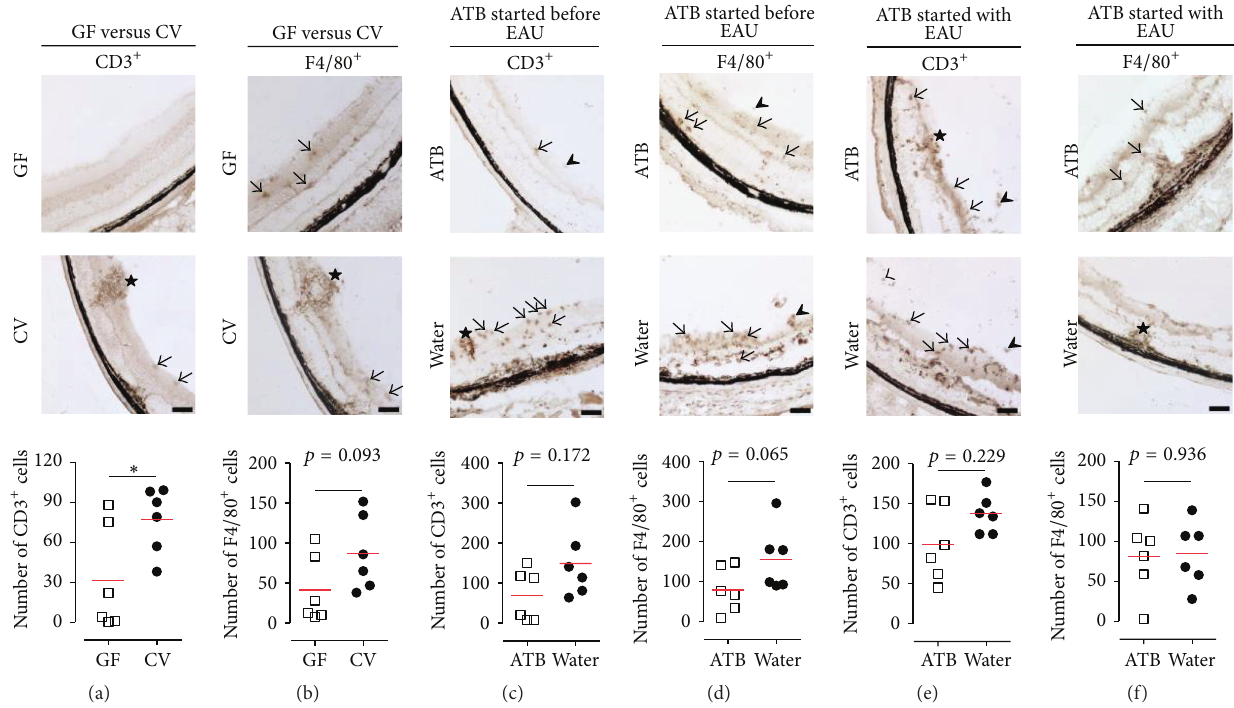
Figure 4: T cell and macrophage infiltration of the retina from germ-free (GF) mice (a, b), from mice treated with antibiotics (ATB) administered from one week (c, d), or from the day of EAU induction (e, f) and conventional (CV, water) mice 35 days after EAU induction. (a, c, e) CD3 + cells (T-lymphocytes) are shown both distributed as single cells in inner and outer retinal layers (arrows), in the vitreous (arrowheads) and concentrated as clumps in granulomas (stars). (b, d, f) F4/80 + cells (macrophages) are either present as single cells, in inner retinal layers (arrows), or accumulated in the periphery of granulomas (stars). Each point in the graphs shows the sum of all positive cells counted in two sections, one from periphery and one from the centre, from one randomly selected eye. The red lines in the graphs represent mean. ∗ 𝑝 < 0.05 (Mann-Whitney